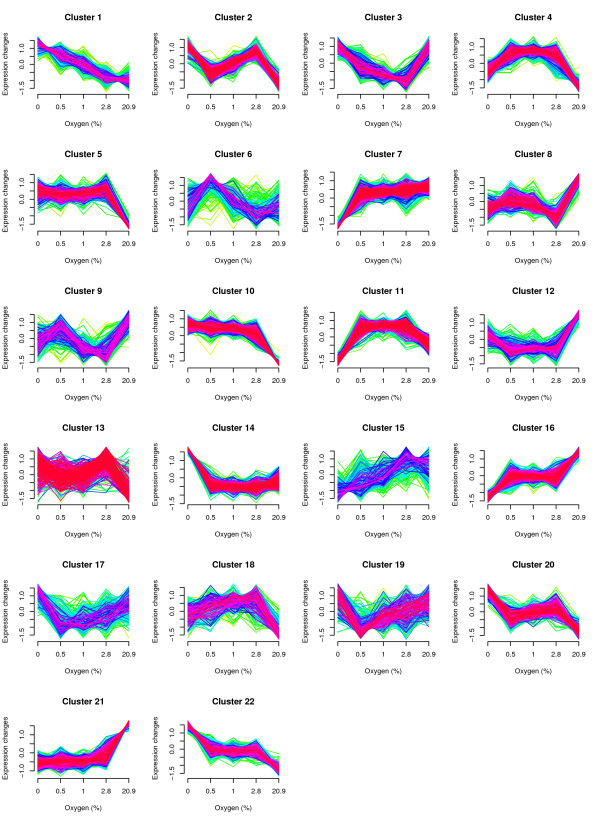
Fuzzy c-means clustering of gene expression patterns in cells grown with 0, 0.5, 1.0, 2.8 and 20.9% oxygen in the feed gas. The clustering was performed with individual samples, but average values for each condition are shown in the graphs. The expression values are centred and scaled around a mean of zero and standard deviation of 1, for all the genes. Red and purple represent genes that have membership values higher than 0.5 while green and yellow represent genes that have membership values below 0.5.